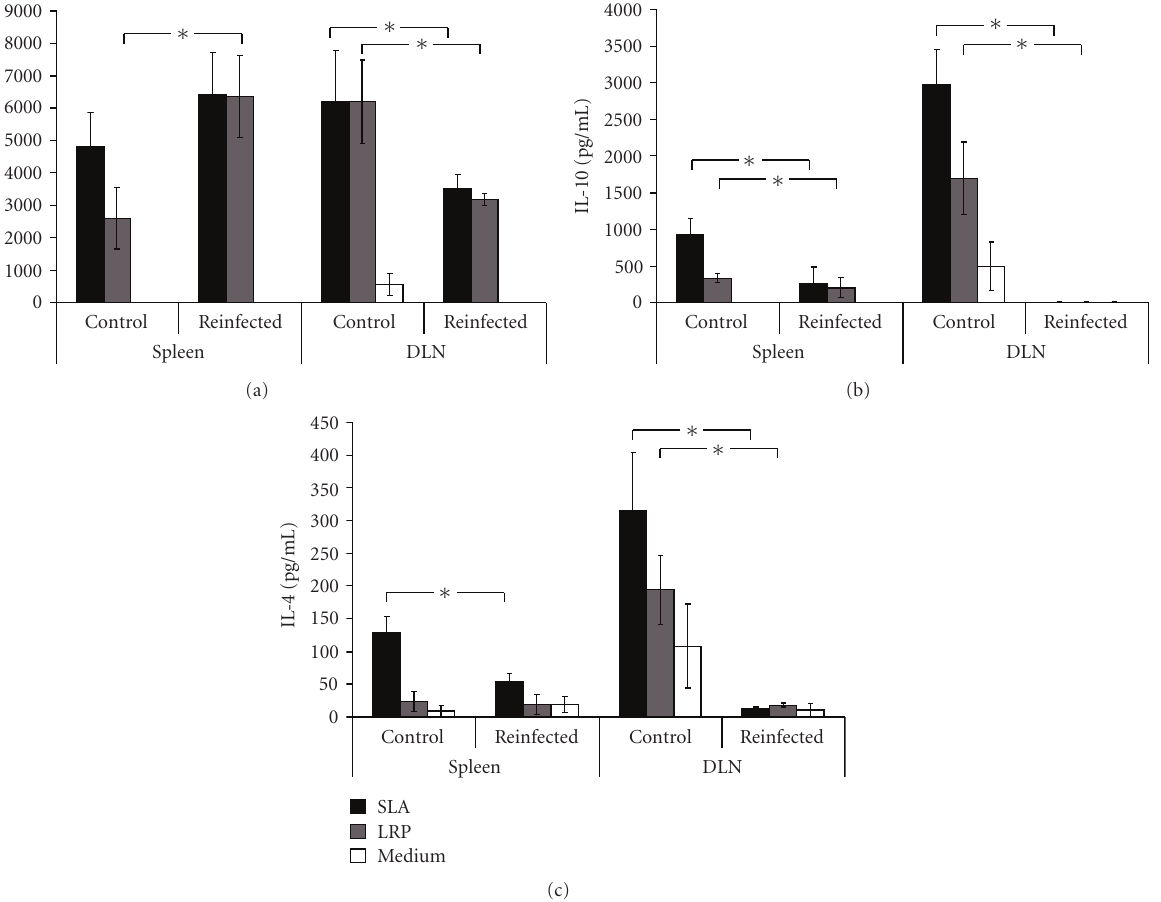
Figure 3: Analysis of the cellular responses. At week seven after ear infection the level of IFN- γ (a), IL-10 (b), and IL-4 (c) was measured by ELISA in the supernatants of spleen and retromaxillar lymph node cells cultures from both mice groups. Cells were in vitro stimulated for 48 hours with 12 μ g/ml of SLA or LRP and medium alone. Results are expressed as the mean ± SD of twelve ears and DLN. ( ∗ P < .